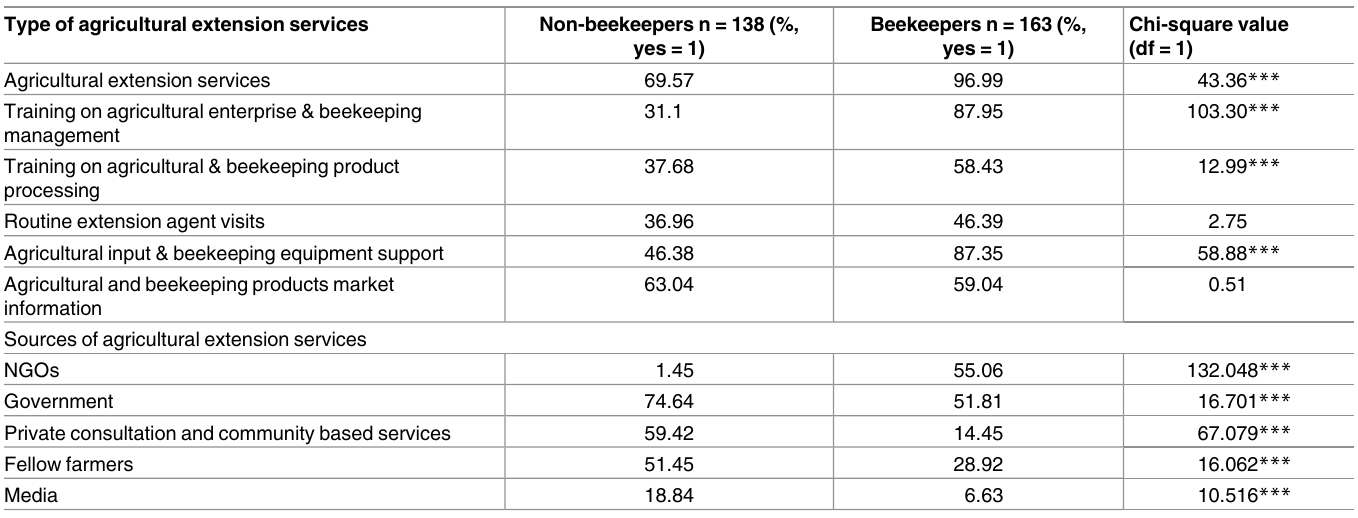
Table 4. Accessibility of agricultural extension